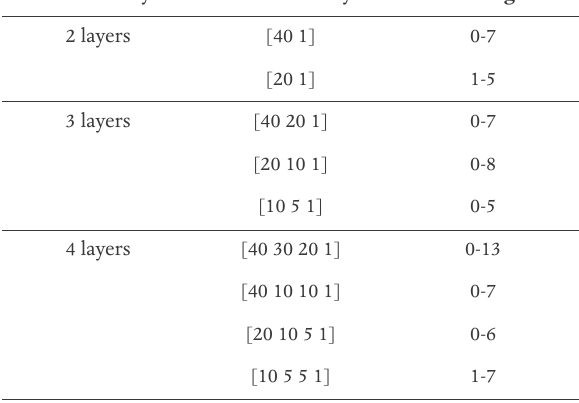
Table 1. Summary of the Kn range for each network parameter set.